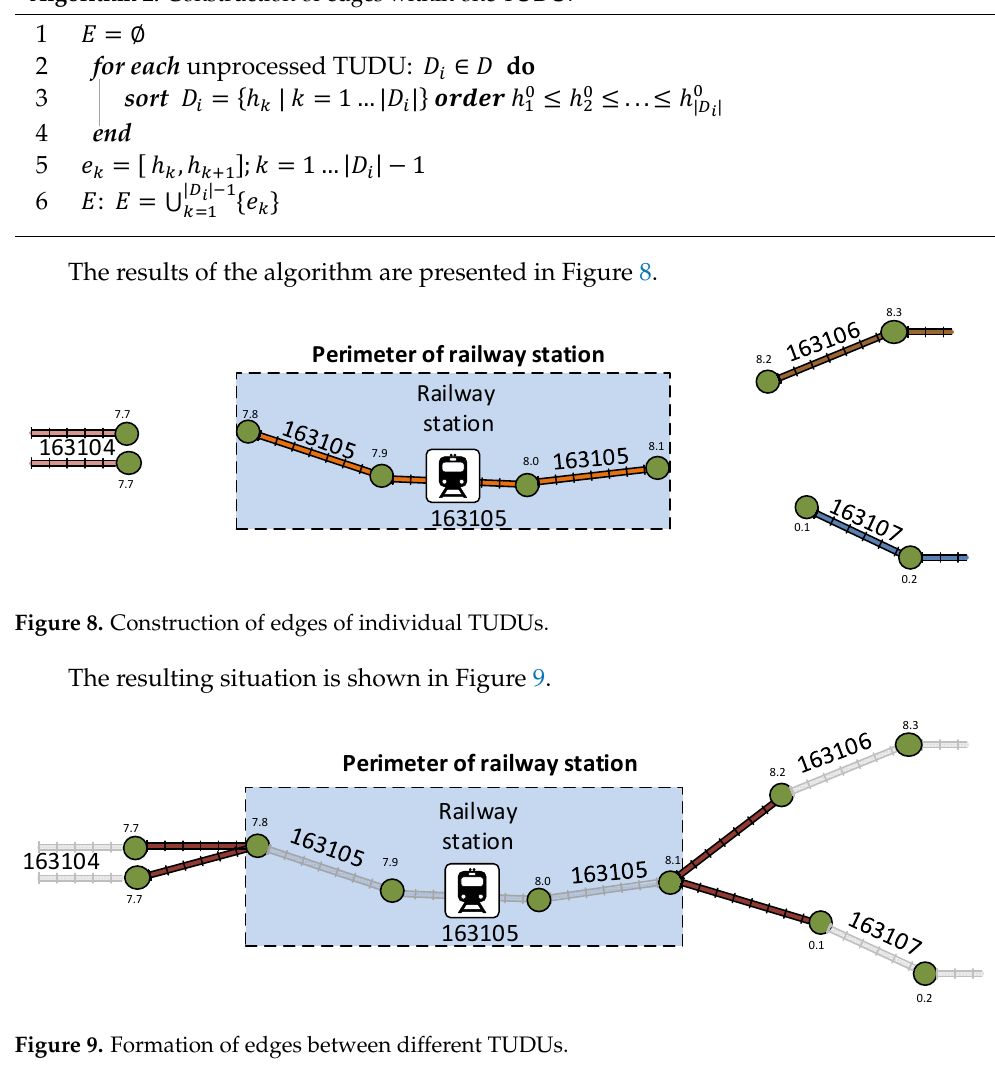
8.3 Figure 9. Formation of edges between different TUDUs.